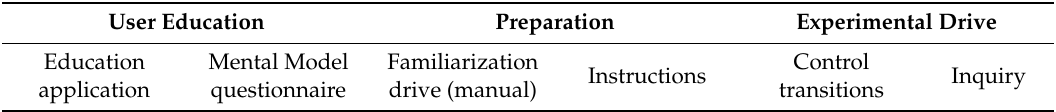
Table 2. Schematic outline of experimental